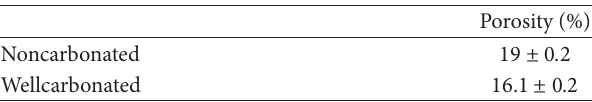
Table 2: Water-accessible porosity of noncarbonated and well- carbonated